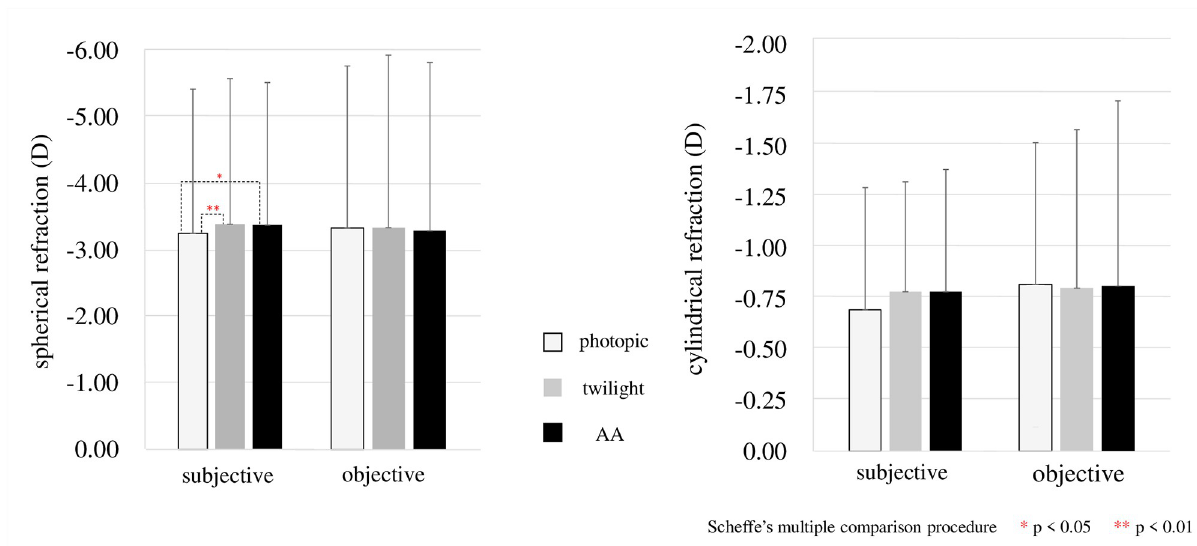
Fig 3. Results of subjective and objective spherical and cylindrical refraction in photopic and twilight and AA are shown. When the results of these three conditions are analyzed using the Friedman test, only subjective spherical refraction shows a difference between the conditions, p = 0.005. Therefore, when Scheffe’s multiple comparison procedure is performed, there is a significant difference in subjective spherical refraction, p = 0.009, between photopic and twilight conditions, and p = 0.049 between photopic and AA.